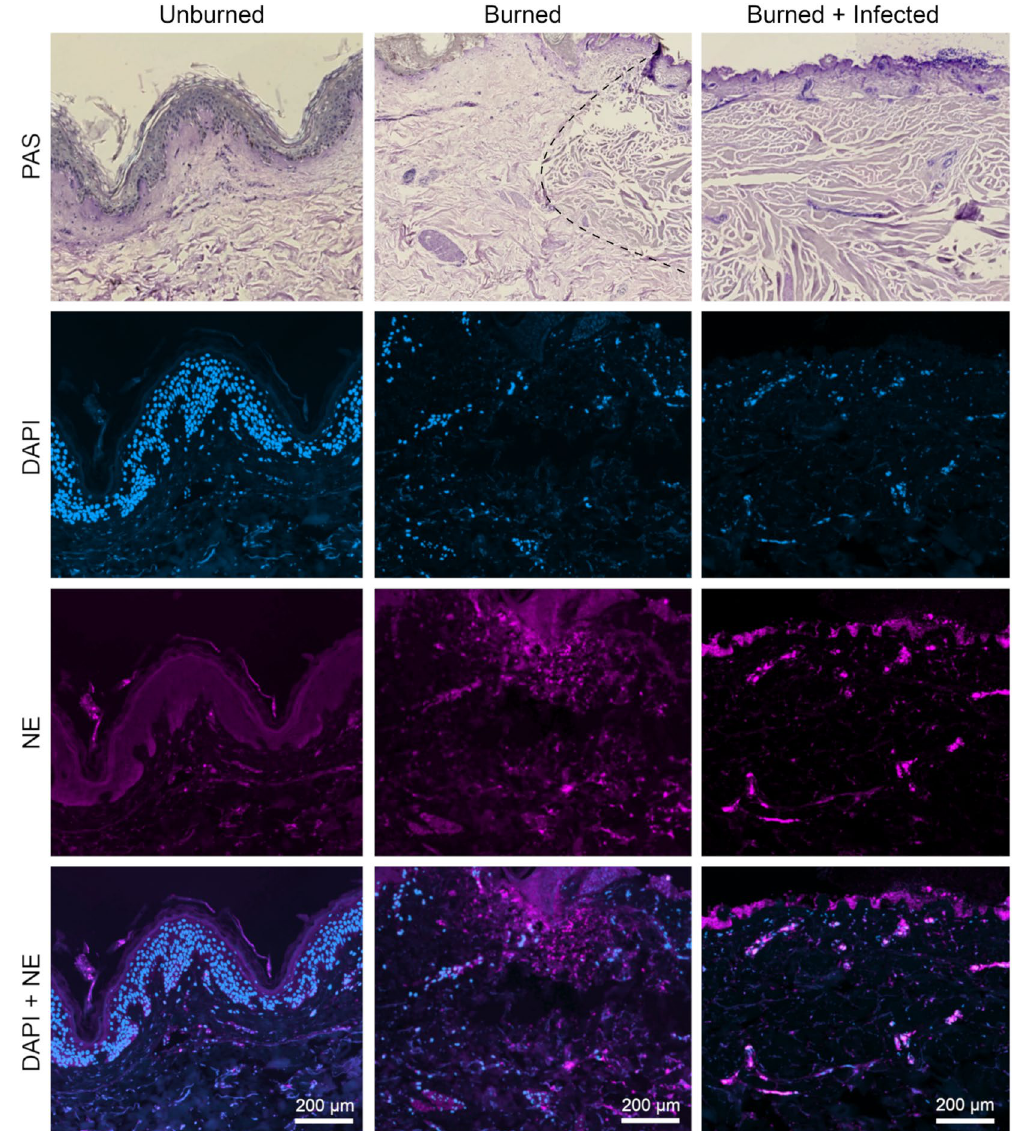
Figure 5. Burning of skin tissue explants attracts neutrophils to the damaged area. Unburned, burned, and burned-infected samples were stained applying PAS for a histological overview, DAPI for localization of nuclei (blue), and AF647 labelled immunofluorescence (pink) for neutrophil elastase (NE). In unburned skin neutrophils are present in the dermal layer whereas in burned and burned-infected skin neutrophils cluster near the epidermis. Defined signals of NE localize tissue-present inactive neutrophils, while diffuse signals indicate release of NE by activated neutrophils. All samples were fixed at day 6. Burn site border is indicated by the dashed line; the tissue to the right of the line is damaged. For the number of skin donors and technical replicates see Table S1. Representative images are shown. Overview slides of the corresponding samples are shown in Fig.